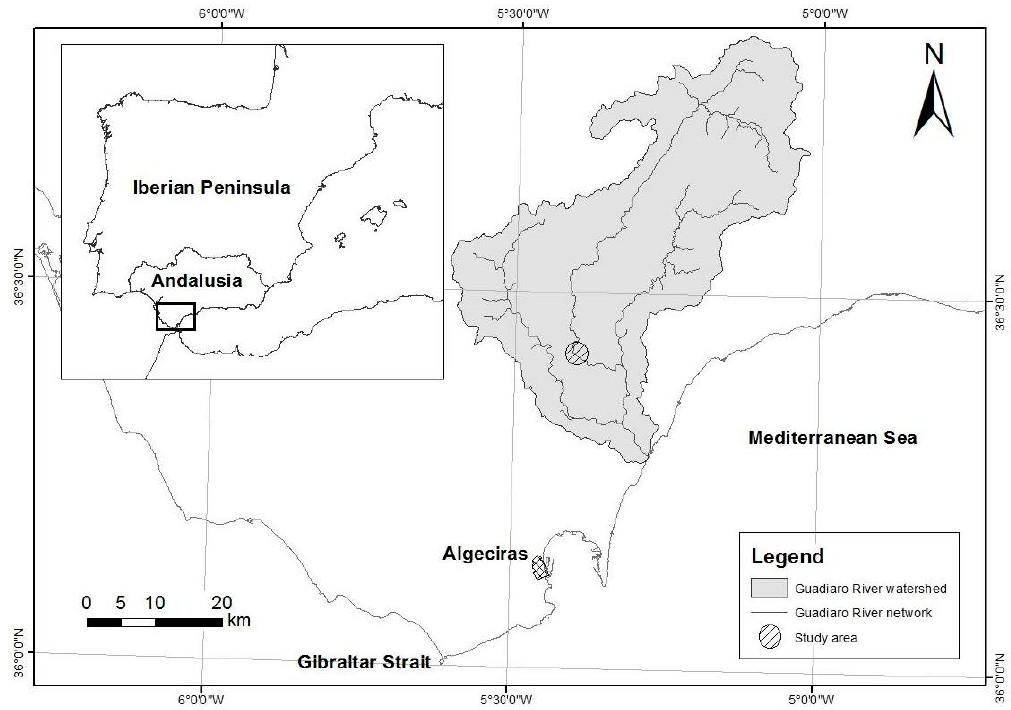
Figure 4. Maps showing the geographical location of the study area and the Guadiaro River watershed.